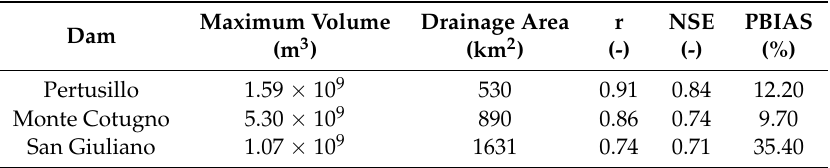
Table 10. Indices of goodness of fit obtained for the three modeled